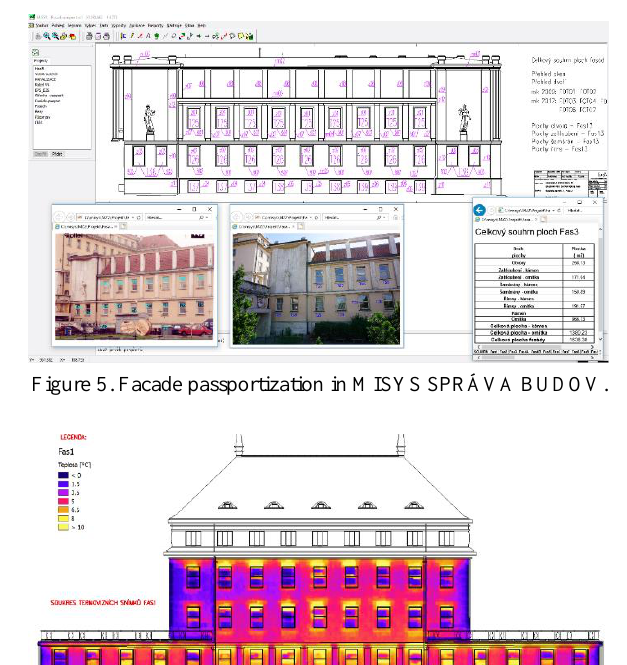
Figure 4. Employee relocation in MISYS SPRÁVA BUDOV.